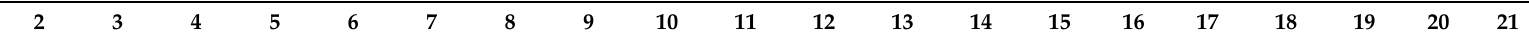
Table 2. Correlations between the study